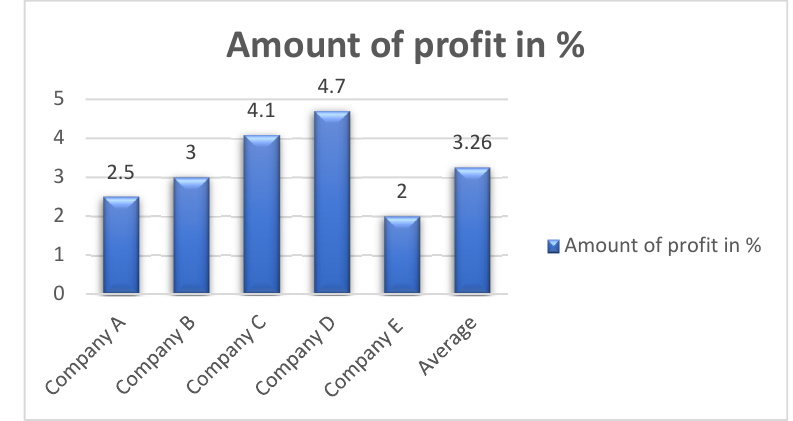
Figure 6. Graphical representation of inputs to the comparative method.